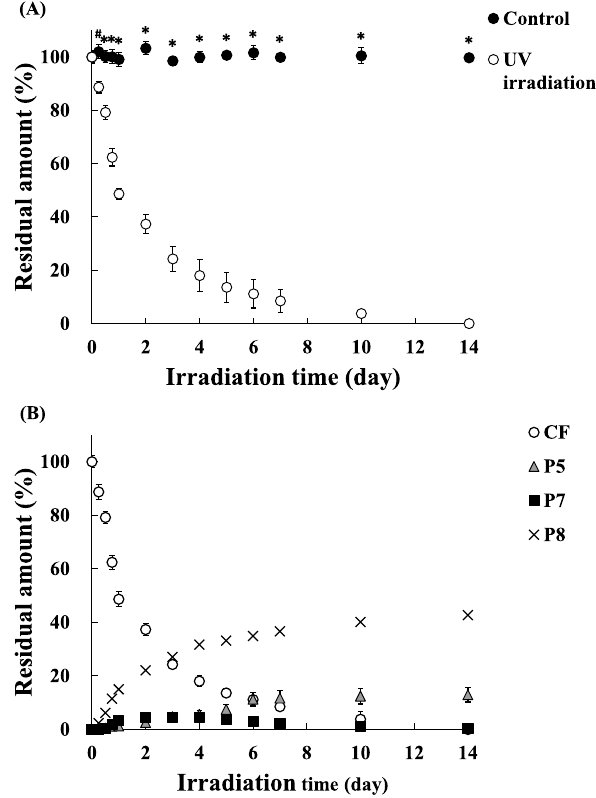
Fig. 3 Residual amounts (%) of CF ( a ) and its three photoproducts ( b ) after UV irradiation. a CF ( ○ ) was monitored by means of HPLC. CF which was not exposed to UV served as the control ( ● ). b Three photoproducts of CF (P5, P7 and P8) were monitored by means of HPLC. Values represent mean ± S.D. (n = 4). # Difference com- pared with control ( p < 0.001). *Difference compared with control ( p <